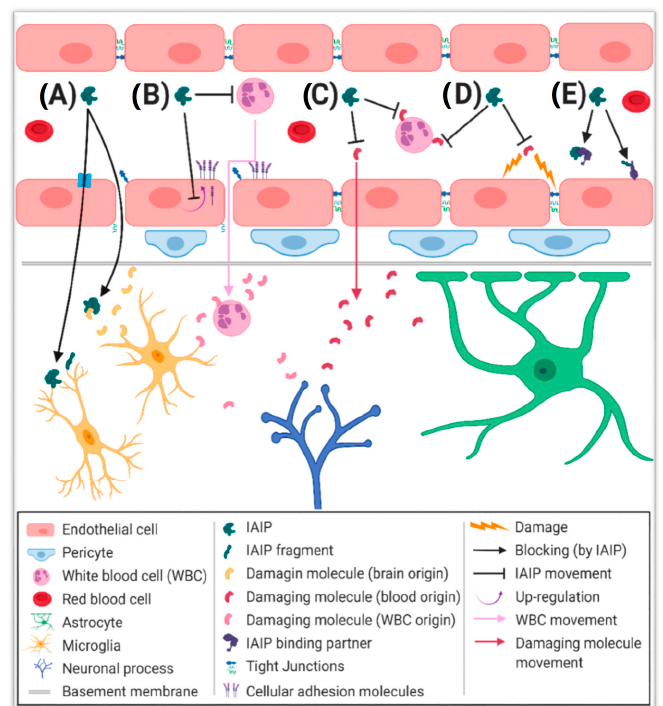
Figure 2. Stylized schematic of potential mechanisms underlying the neuroprotective properties of inter-alpha inhibitor protein (IAIP) treatment after exposure to hypoxia-ischemia (HI) in neonatal subjects. Legends for the elements in the Figure are illustrated below the Figure. The blood-brain barrier (BBB) is shown with endothelial cells joined by tight junction proteins. Red blood cells and white blood cells are depicted in the bloodstream. Pericytes line the vascular endothelium below the basement membrane. Astrocytes have endfeet that line the neurovascular unit, microglia, and neuronal processes are also in close proximity to the vasculature. The potential actions of IAIPs are also shown: ( A ) IAIPs or smaller subunit components of IAIPs could cross the BBB through paracellular transfer that is increased after HI damage or through yet to be identified transcellular pathways. Once within the central nervous system (CNS), IAIPs or IAIP components could interact with molecules or cells within the brain directly; ( B ) IAIPs might attenuate the transfer of activated immune cells into the brain by limiting the up-regulation of adhesion molecules on endothelial cells, altering the ability of immune cells to cross the vasculature or transforming immune cells to a non-damaging phenotype; ( C ) IAIPs may limit the transfer of harmful molecules into brain tissue by either directly inactivating the molecule or by preventing its production, release, or BBB passage; ( D ) Through similar mechanisms in ( C ), IAIPs might decrease the amount of harmful molecules in the systemic circulation, thereby preventing those molecules from damaging the integrity of the BBB; ( E ) IAIPs or components of IAIPs may form molecular complexes that either cross the BBB, line the BBB vasculature, or have downstream e ff ects independent of the original IAIP molecule administered. Although the potential mechanism(s) of action of IAIPs depicted in ( A – E ) have some support, as summarized above, many of the specific molecular mechanism(s) at the BBB endothelium require future investigation. Cellular and molecular size, distribution and neurovascular coverage are not necessarily accurately depicted to allow for illustration of the potential mechanism(s) of action of IAIPs. Illustration was created with